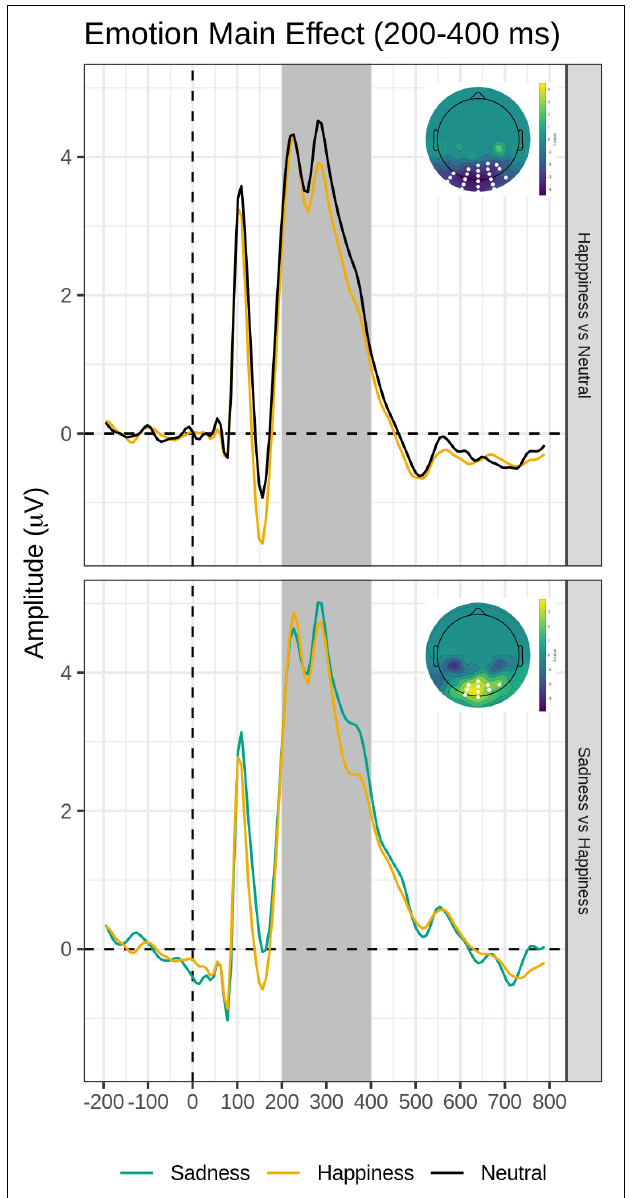
FIGURE 5 | Emotion main effect of the intermediate time window (200–400 ms). Grand-average waveforms for Happy vs. Neutral (top) and Sad vs. Happy (bottom) contrasts for each electrode included identified by the significant negative or positive clusters. Scalp topography maps of the relevant contrasts displaying the significant clusters (with the significant electrodes highlighted in white). Covert and Overt tasks are combined.